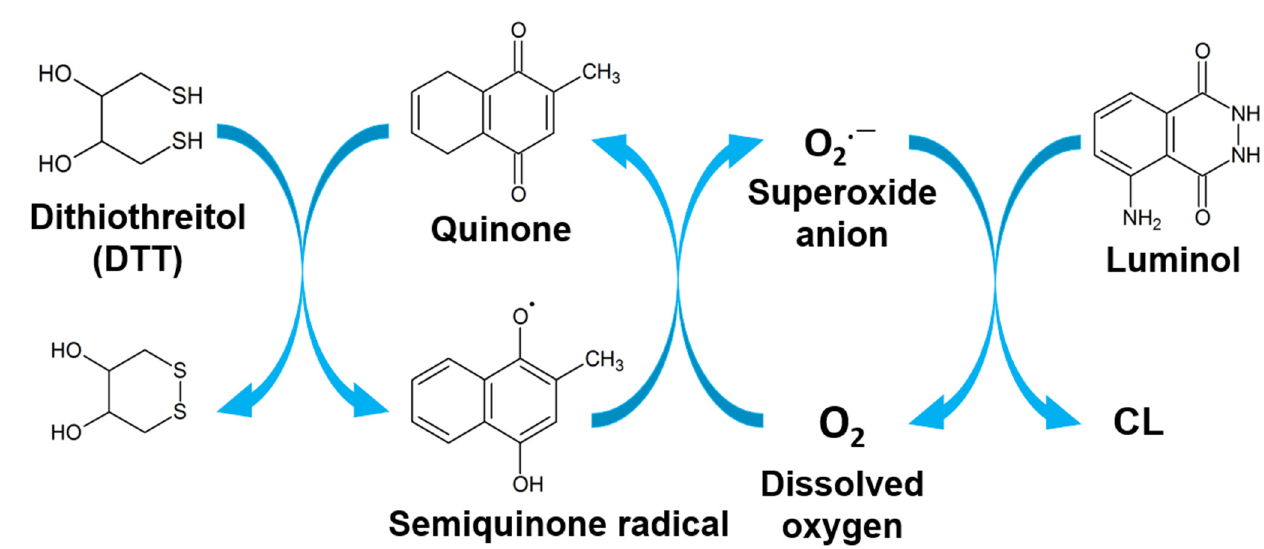
Scheme 1. Mechanism of the redox cycle of quinone for CL detection.